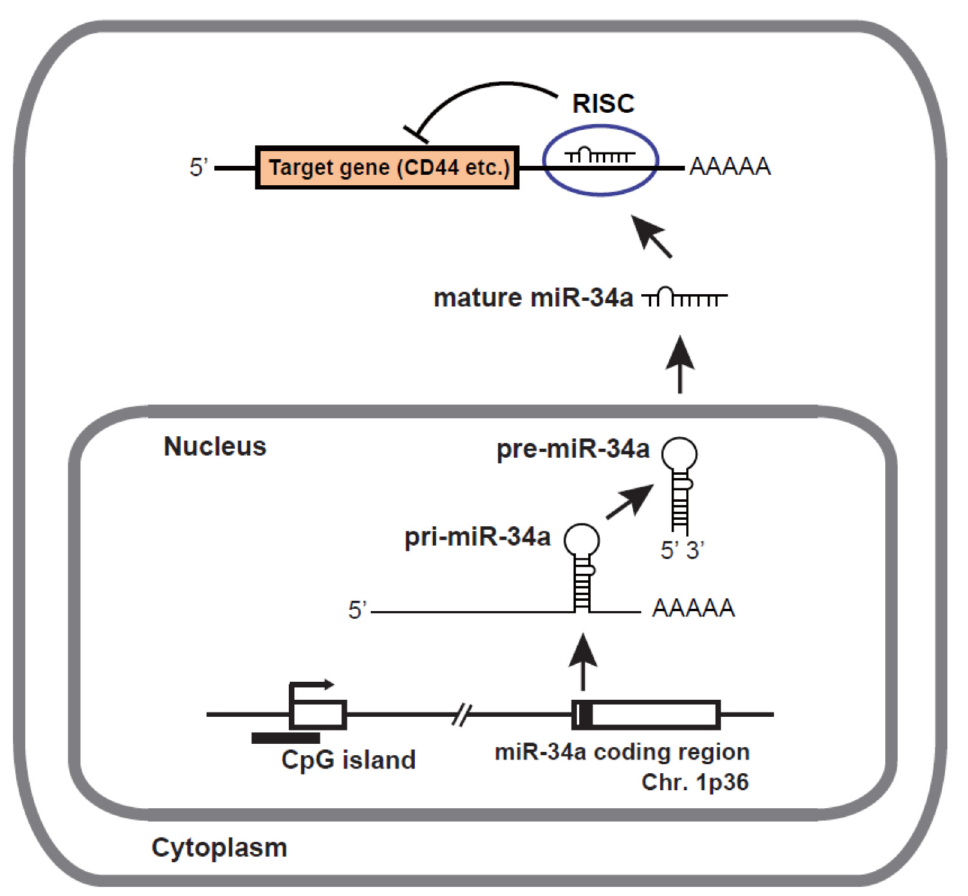
Figure 1. Biogenesis of miR-34a. miR-34a genes are transcribed from TSS by RNA pol II to form pri-miR-34a, which is capped with 7-methylguanosine and polyadenylated (AAAAA). Drosha and its co-factor DGCR8 process pri-miR-34a into pre-miR-34a. Pre-miR-34a is transported into the cytoplasm and subsequently cleaved by Dicer into mature miRNAs. Mature miR-34a is then loaded into RISC, where miR-34a down-regulates specific gene products by translational repression via binding to partially